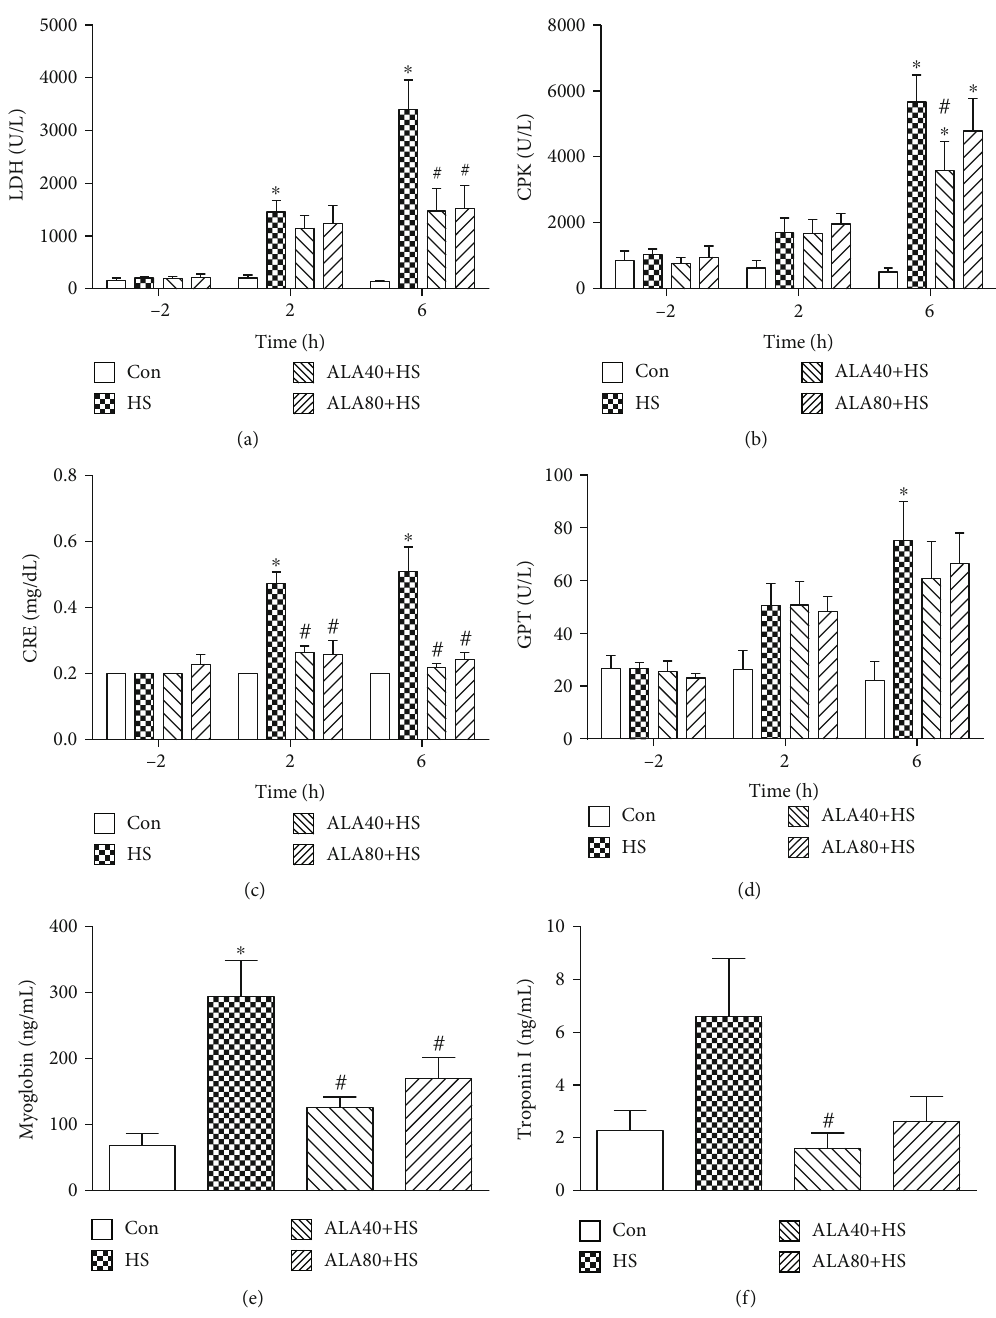
Figure 3: E ff ects of pretreatment with α -lipoic acid (ALA) on plasma levels of (a) lactate dehydrogenase (LDH), (b) creatine phosphokinase (CPK), (c) creatinine (CRE), (d) glutamic pyruvate transaminase (GPT), (e) myoglobin, and (f) troponin I in heat stroke rats. Data are expressed as mean ± SEM ( n = 5 -11). ∗ P < 0 : 05 versus Con; # P < 0 : 05 versus